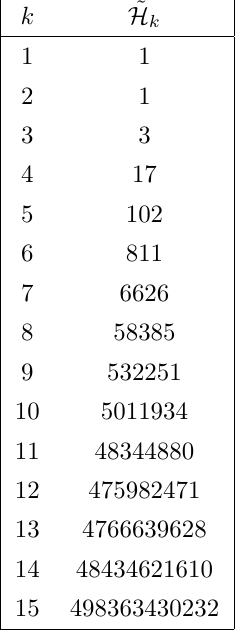
Table 1. The number of cyclic classes of Gr( k; 5 k ) Yangian invariants for k (cid:20) 15, given by (4.2). Also the number of plane 5-gonal cacti with k pentagons [20] (see also